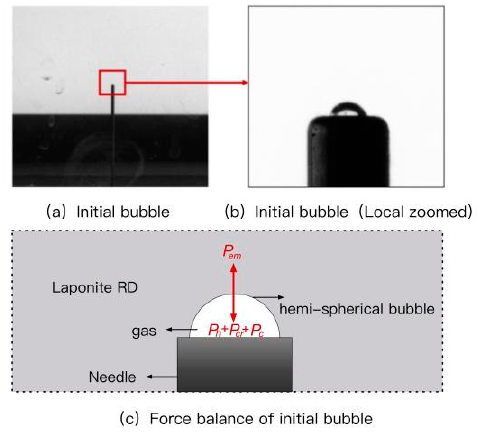
Figure 4. Force balance diagram.